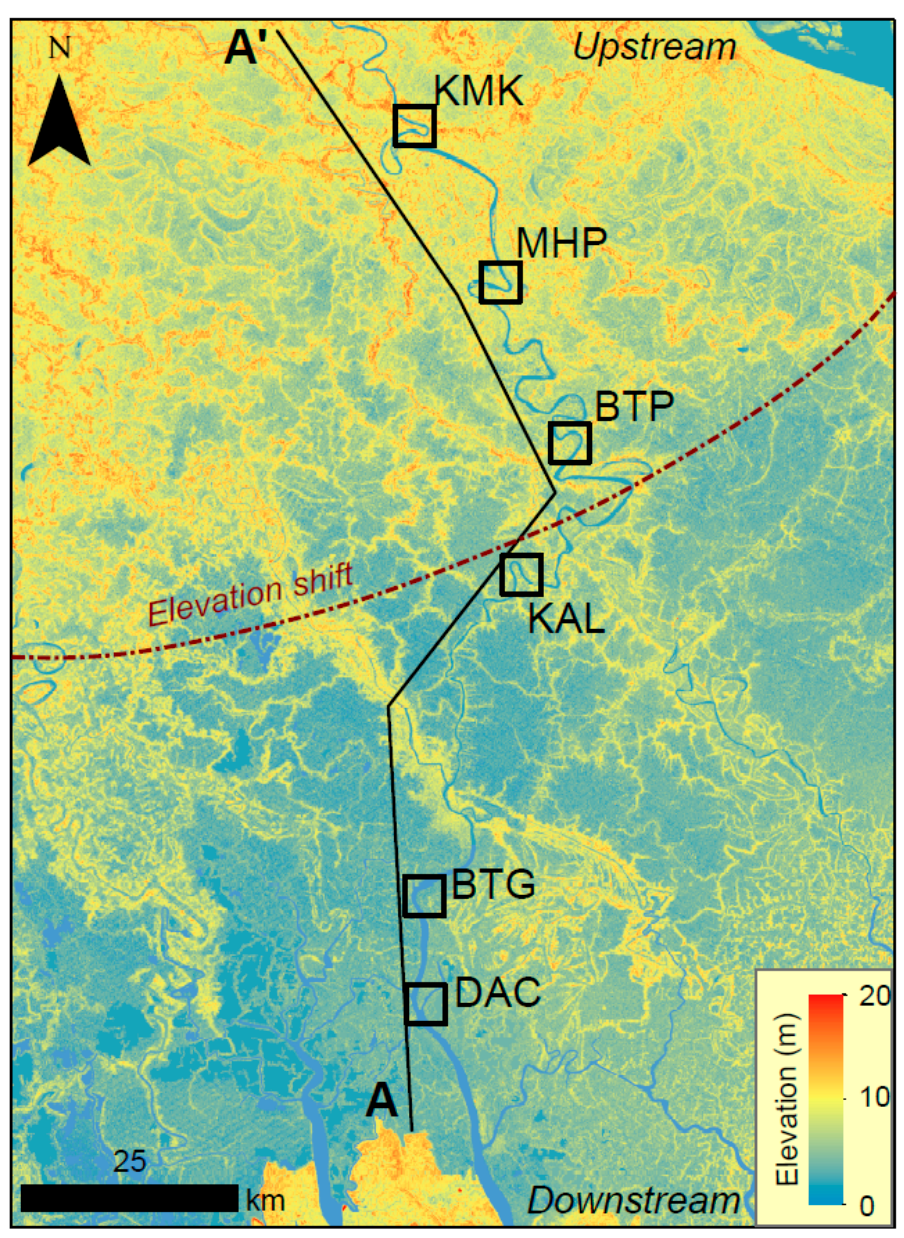
Figure 2. Digital elevation model (DEM) of southwest Bangladesh constructed from the 2000 Shuttle Radar Topography Mission data illustrating a distinct shift in topography. Transect A-A’ runs alongside the Gorai River from the northern edge of the Sundarbans Forest to the Ganges-Gorai offtake.